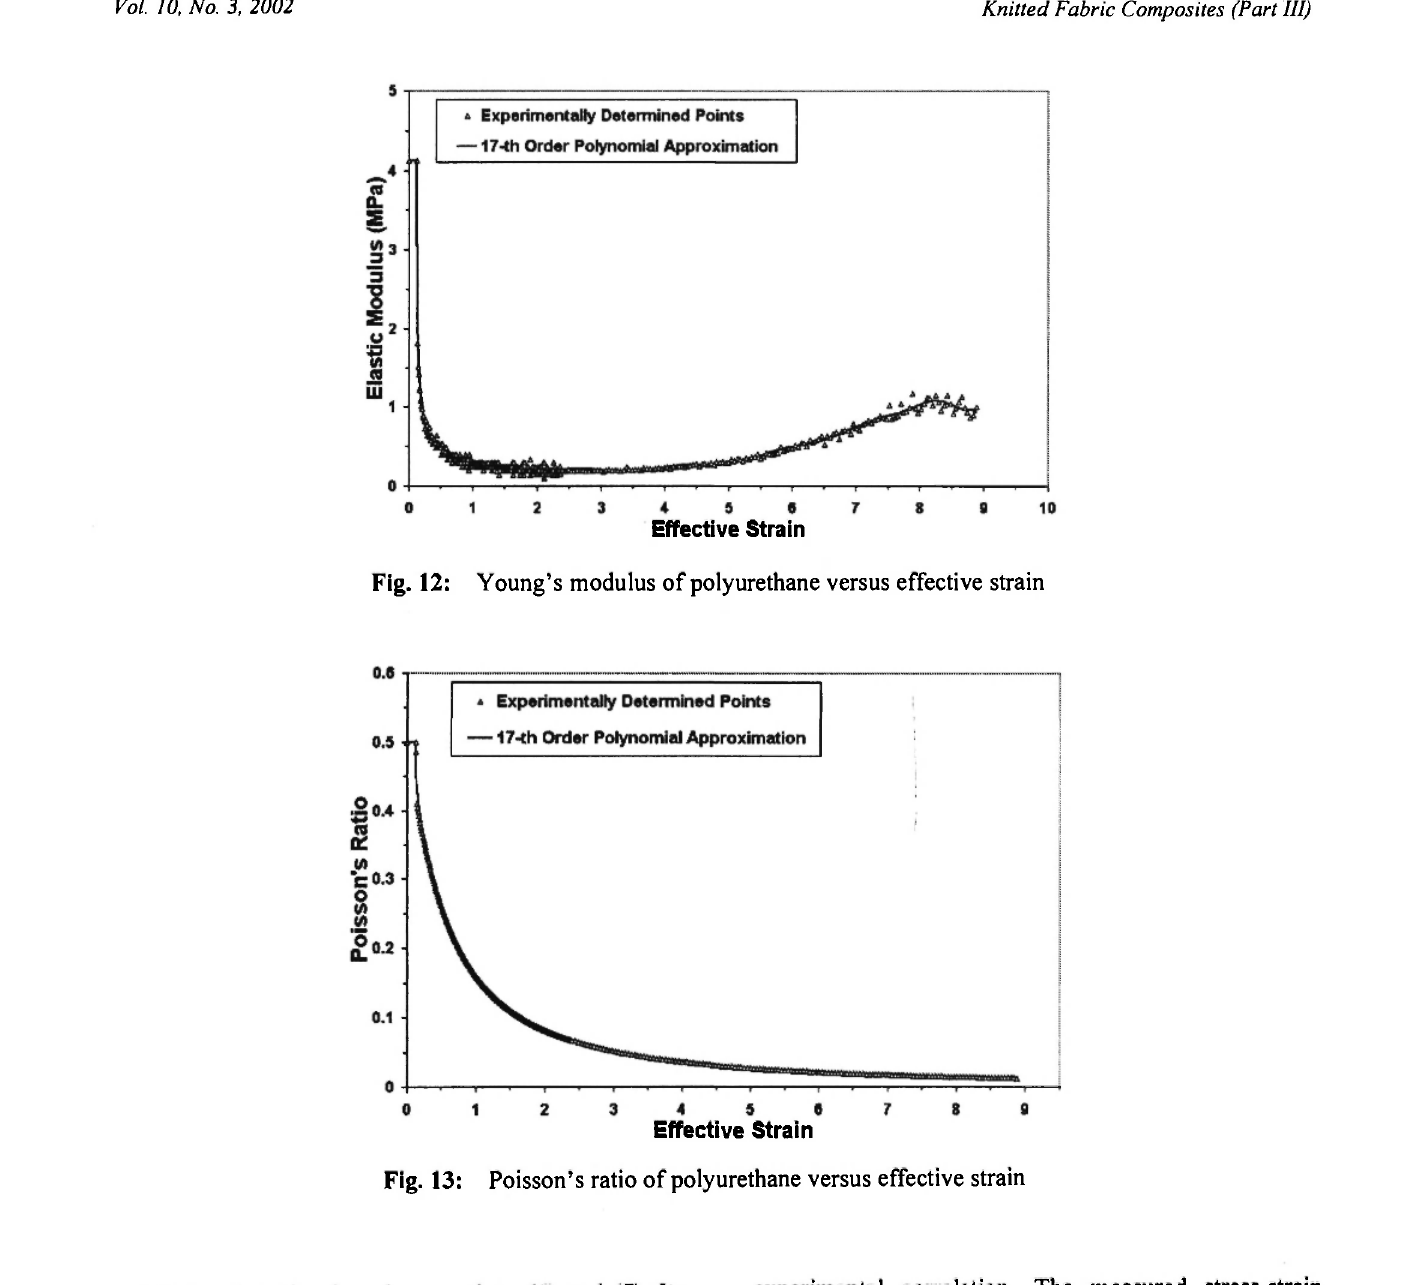
Fig. 13: Poisson's ratio of polyurethane versus effective